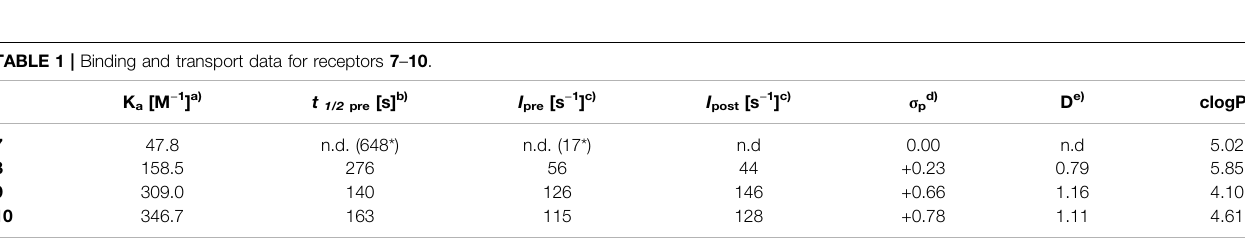
TABLE 1 | Binding and transport data for receptors 7 – 10